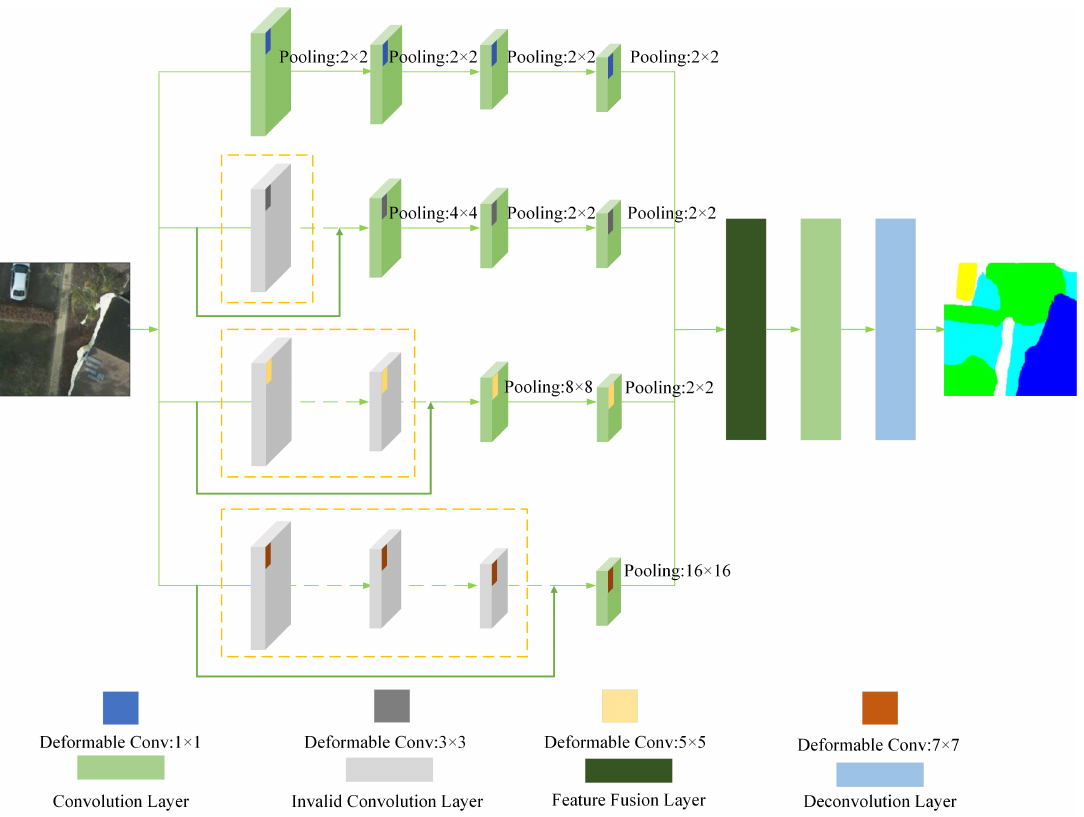
Figure 3. The framework of the modified multiscale deformable convolutional neural network